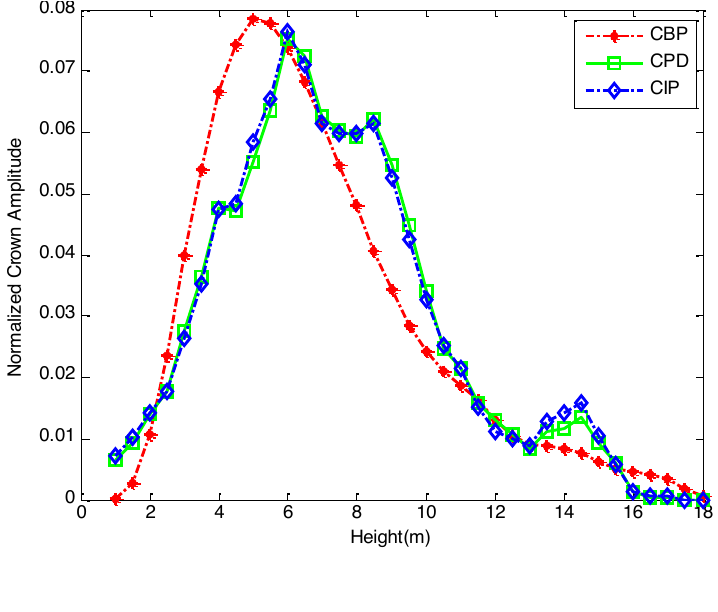
Figure 7. Vertical profiles for Subplot S7. CBP = canopy biomass profile; CPD = canopy point density profile; CIP = canopy intensity profile; normalized crown amplitude means the normalized values for CBP, CBD and